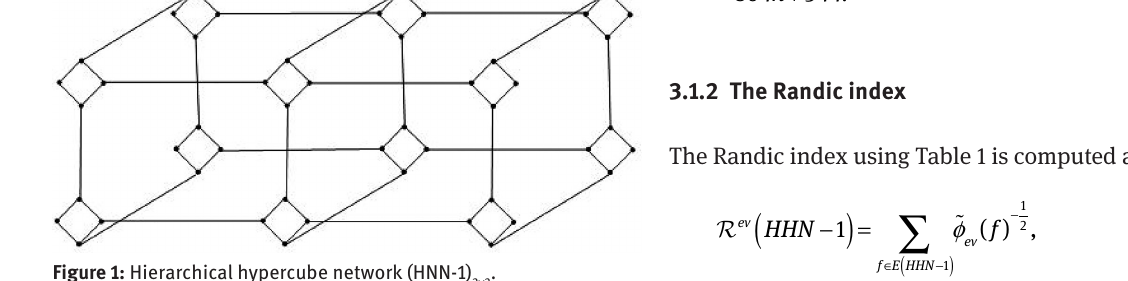
Figure 1: Hierarchical hypercube network (HNN-1)